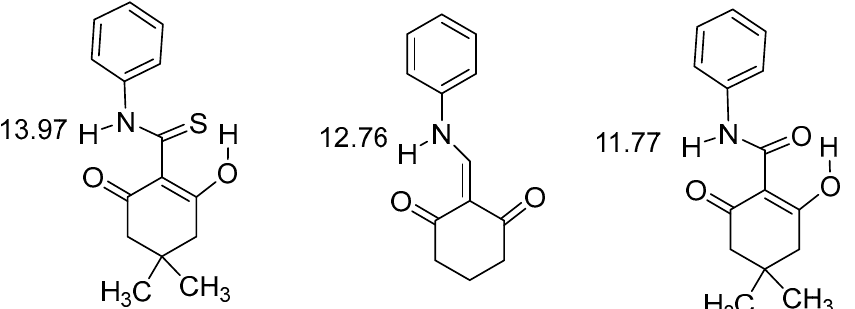
Figure 8. Comparison of amides and thioamides as donors. The numbers are the NH chemical shifts in ppm. For the amide and thioamide the methyl derivatives have chemical shifts of 9.69 and 12.20 ppm. Taken from [31]. The amine is from [24]. in Figure 9.